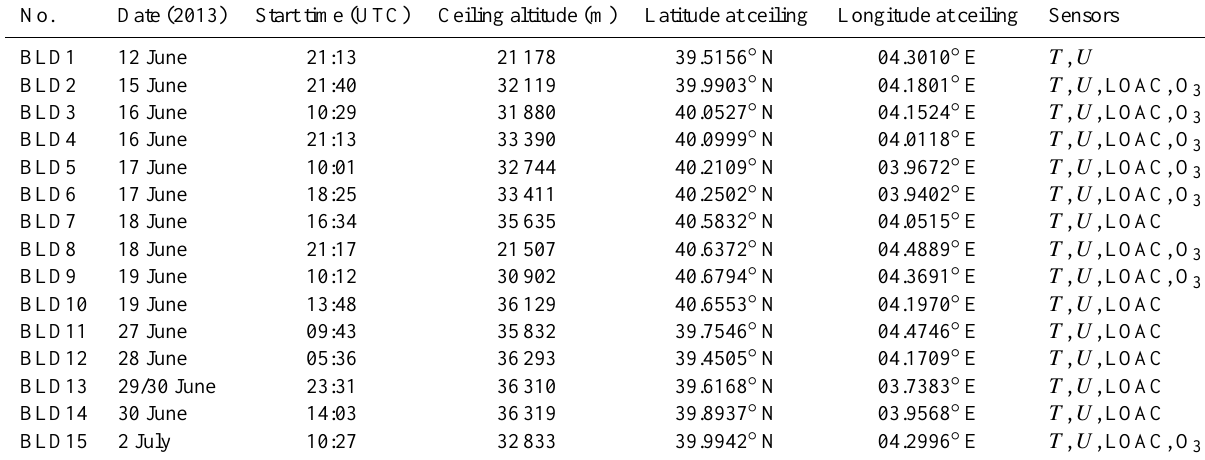
Table 5. Characteristics of the 14 BPCL drifting balloon flights.